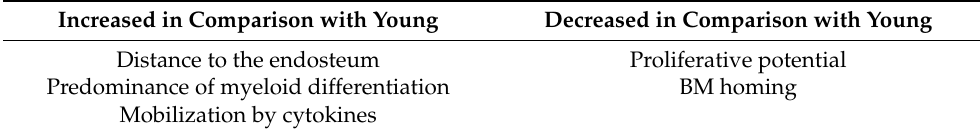
Table 3. Aging-related changes in HSC, adapted from